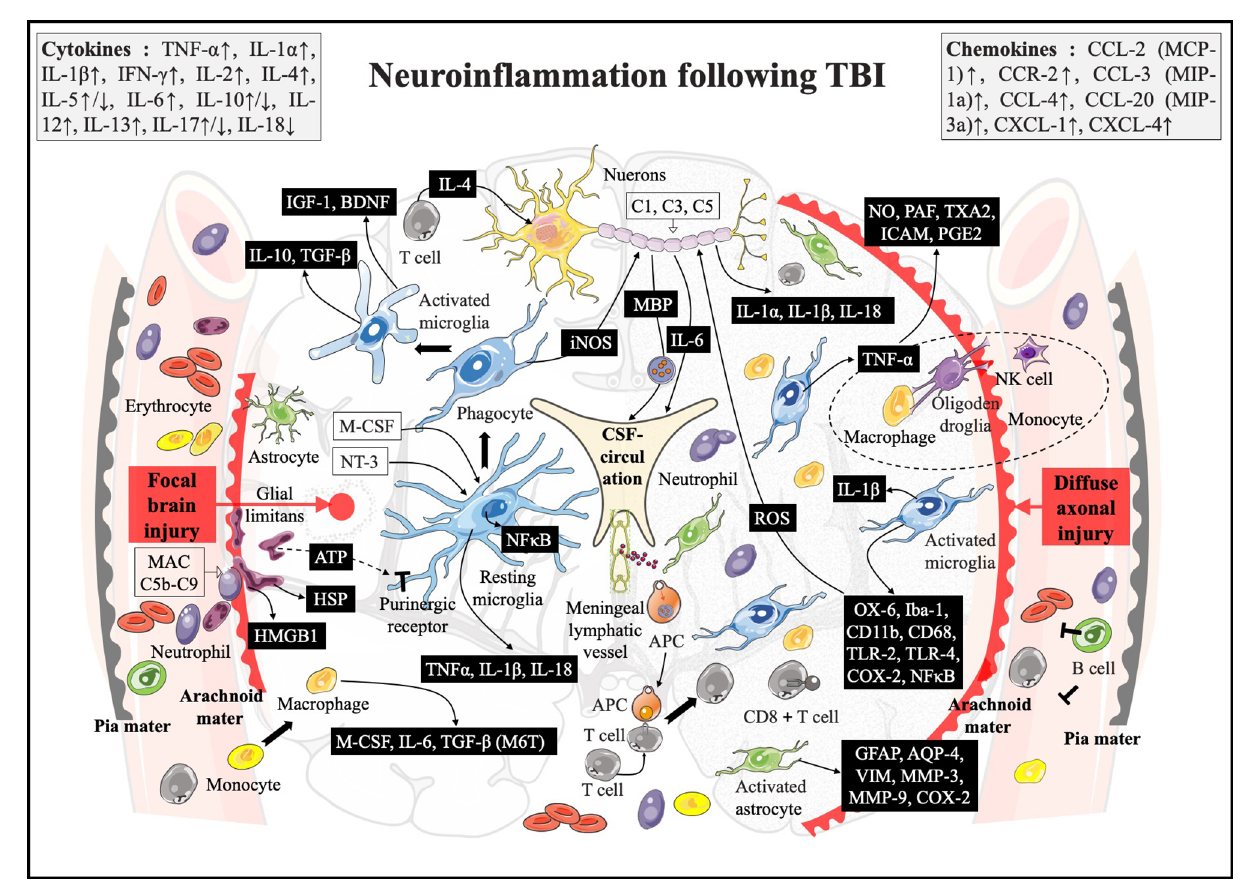
FIGURE 2 | A brief comparison of the neuroin fl ammation in two main subtypes of TBI. In the FBI (the left side), it begins with the complement activation and the initiators (including HMGB1, HSP, and ATP) releasing from the damaged meninges and parenchyma within minutes following brain injury. Those compliments will bind to DAMP sensors such as purinergic receptors and TLRs that immediately induce resident microglia activation followed by in fl ammasome assembling. Then, a variable number of cytokines and chemokines generating and the NF- k B translocating into the nuclei induce an immunological reprogramming. Meanwhile, it can also induce the recruitment of neutrophils and macrophages to the injured meninges and/or perivascular regions, by which more chemokines and cytokines proliferate and the in fl ammatory response ampli fi es. In the DAI (the right side), in addition to the above-mentioned processes, the MBP is released from the damaged neural myelin involved in CSF circulation. T cells can be recruited to the damage site via a damaged BBB and/or meningeal lymphatic vessel, and the local APCs subsequently present it. Moreover, massively activated astrocytes and oligodendrocytes and their crosstalk can participate in immunogenic signal activation, which takes precedence over peripheral immune in fi ltration (such as neutrophils and